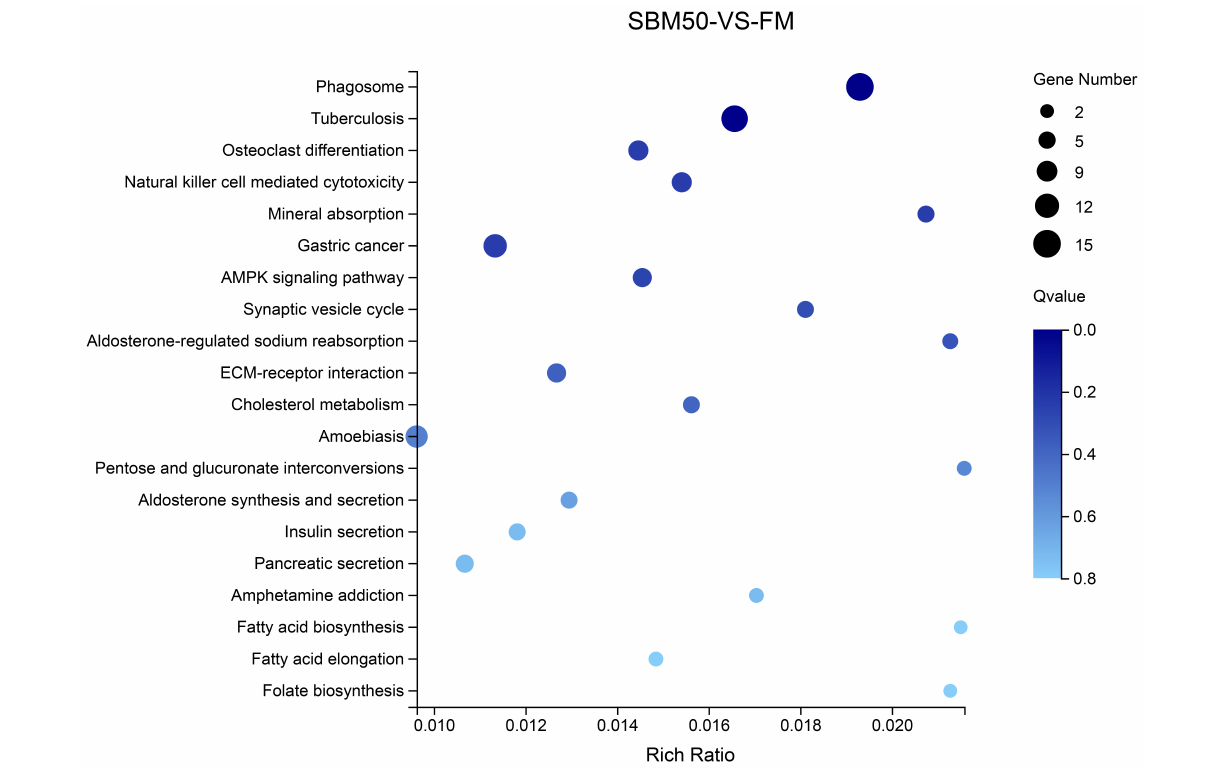
FIGURE 7 | The top 20 KEGG pathways of differential target genes of differentially expressed miRNAs (DEmiRNAs) in the FM and SBM50 groups. The horizontal axis represents the rich ratio, and the vertical axis represents the name of the KEGG pathway. The size of the bubble represents the number of genes annotated to the pathway. The color indicates the enriched Q